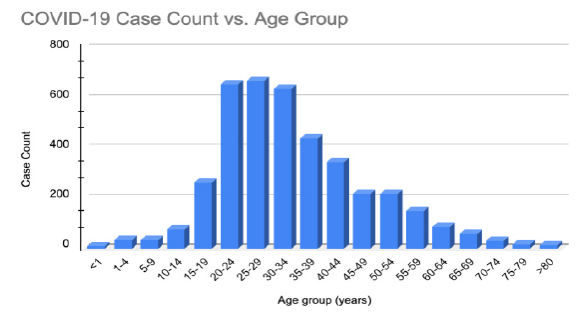
Figure 1: COVID-19 Case Count vs. Age